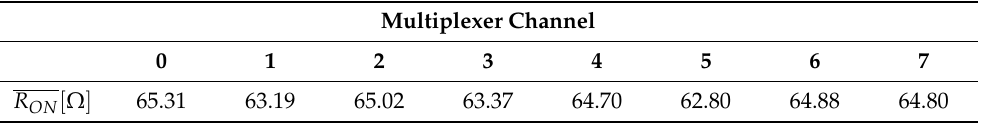
Table 3. Table with reported results of the characterization of R ON resistance of eight channels of the CD74HC4067